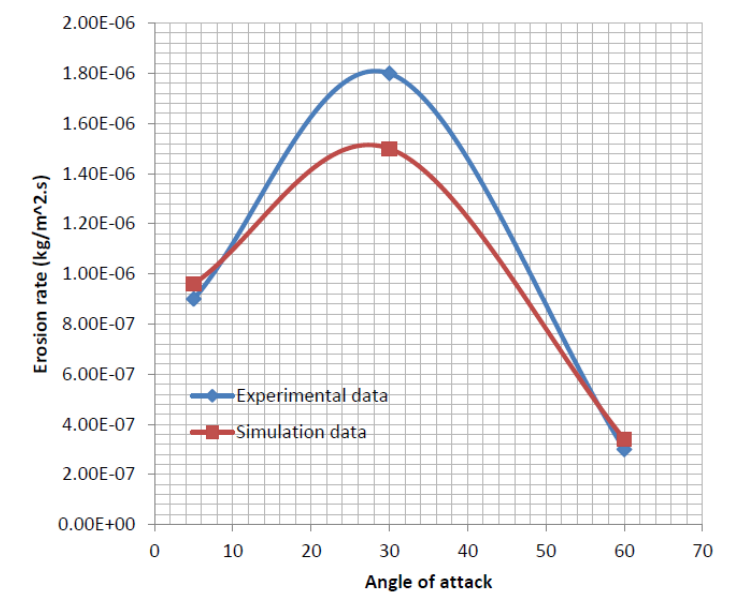
Figure 13: Comparison of experimental and simulation results for erosion rate at different angle of